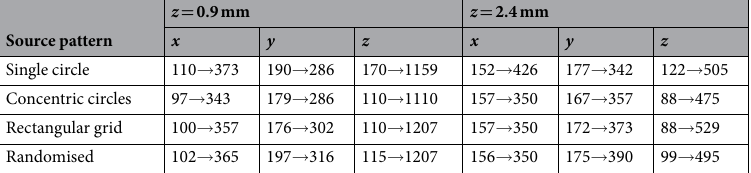
Table 1. Minimum and maximum spatial extents ( μ m) of the 3D point spread functions obtained from 81 measurements along two planes located at axial depths of z = 0.9 mm and z = 2.4 mm. Point spread functions were measured for four different source location patterns, and their spatial extents are given as minimum value → maximum